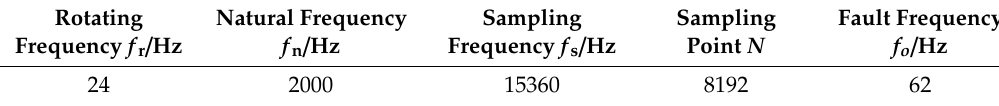
Table 1. The parameters of outer fault simulation signal.